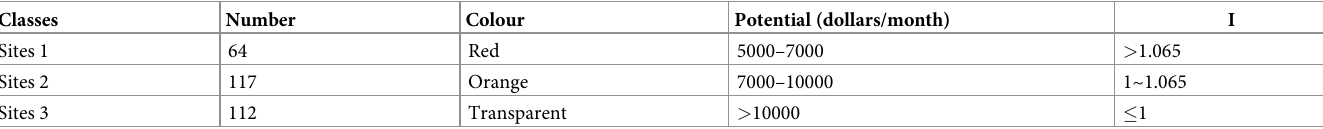
Table 7. Number and consumption potentiality of each